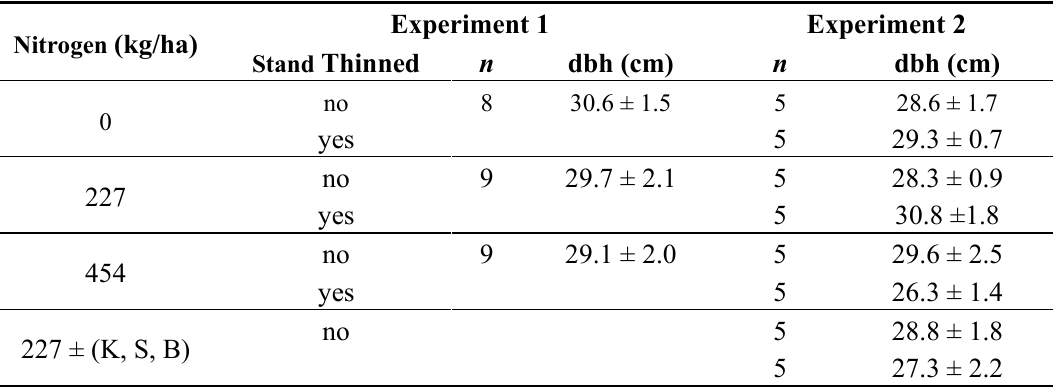
Table 1. Treatment and tree diameters (cm + SEM) for the lodgepole pines in two nitrogen fertilization experiments. Individual trees in Experiment 1 received 1 of 3 treatments (0, 200 or 400 kg/ha of N applied as urea). Trees in Experiment 2 were in stands that either received no thinning treatment or were thinned to a stand density of approximately 40 trees/ha. Individual trees were then fertilized with N applied as urea at 0, 227, 454 or 227 (plus additional nutrients)